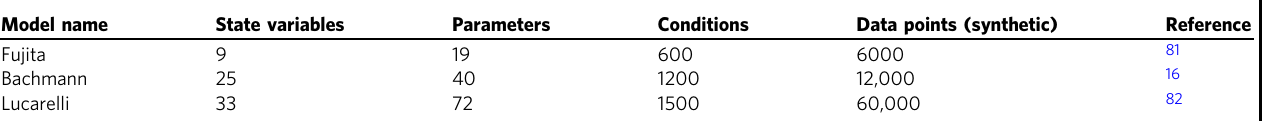
(Fig. 2a). Details on the three benchmark examples and on the arti fi cial datasets are given in the Methods section.